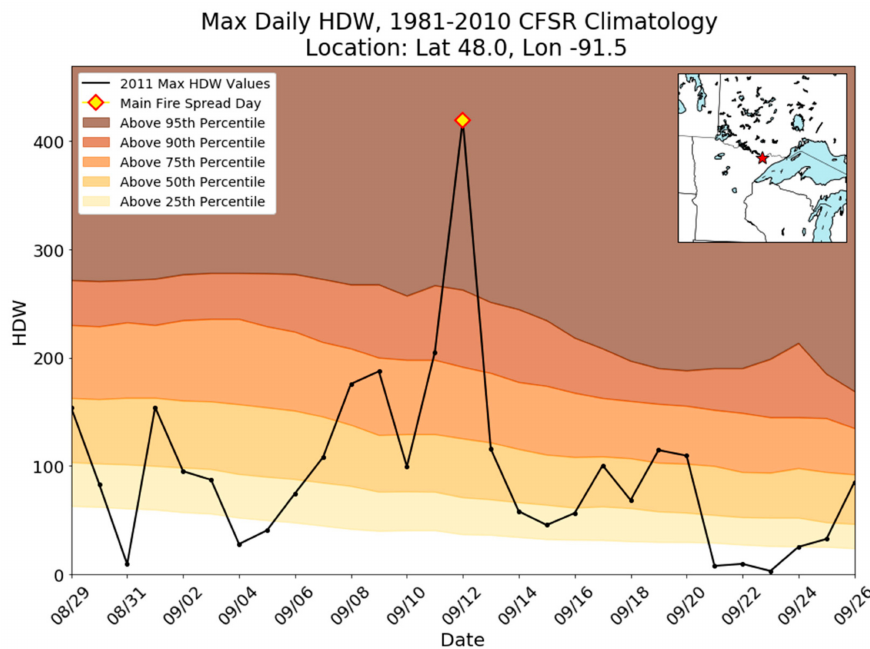
Figure 4. HDW climatological percentiles as in Figure 1, but for the 29-day period examined in [1] for the Pagami Creek Fire (centered on 12 September, the largest fire-spread day) at grid point 48.0 ◦ N, 91.5 ◦ W. The black trace represents HDW values calculated from CFSR for the same 29-day period in